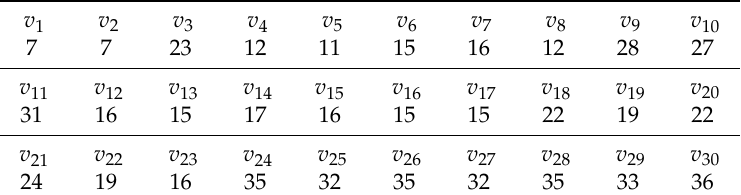
Table 5. Delay under AAPS scheme.